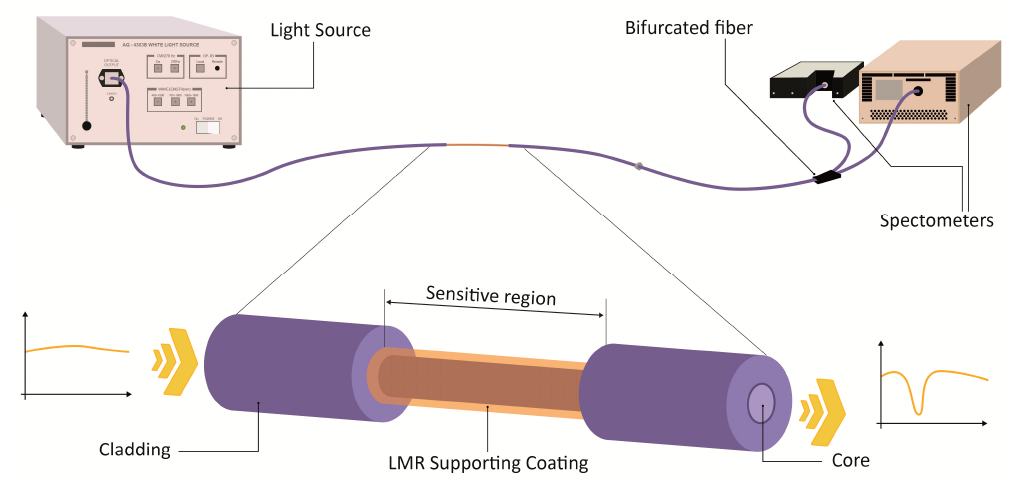
Figure 3. Typical setup involving a cladding-removed multimode optical fiber (CRMOF) for the fabrication of a LMR-based refractometer. In this case, a bifurcated fiber was included to observe a wider spectrum using two refractometers.